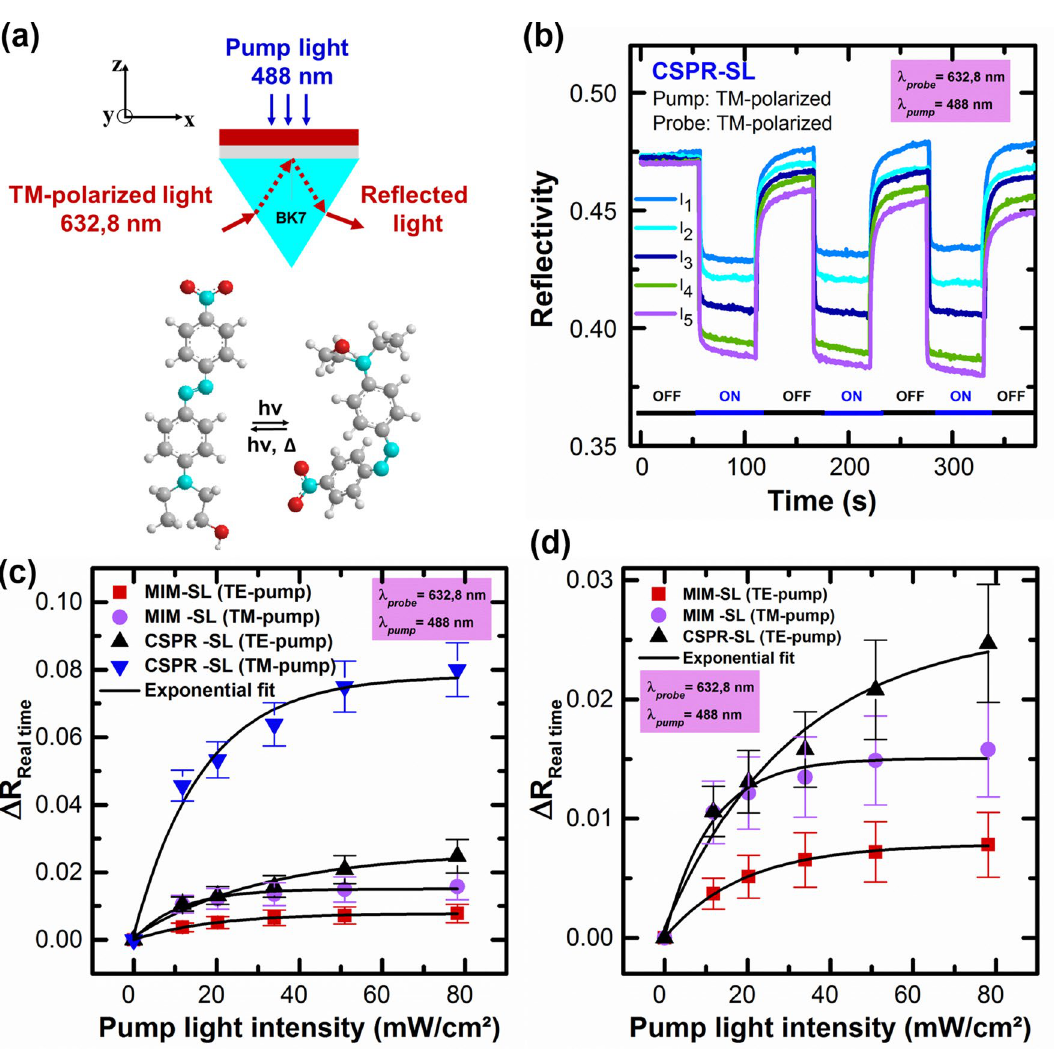
Figure 5. ( a ) Schematics of pump-probe experimental configuration and trans ↔ cis isomerization of DR1. ( b ) TM mode reflectivity cycling of the CSPR mode by photoisomerization of DR1 in the sensing layer (SL) at five different pump intensities, i.e. I 1 = 11.77 mW/cm 2 , I 2 = 20.30 mW/cm 2 , I 3 = 33.91 mW/cm 2 , 2 . The on–off cycles of the pump light are indicated. ( c ) ∆R 2 , I I 5 = 78.16 mW/cm 4 = 50.92 mW/cm measurements of the probe TM mode reflectivity change of MIM and CSPR under TE and TM pump irradiation, and ( d ) is the zoom of ( c ) for small values of